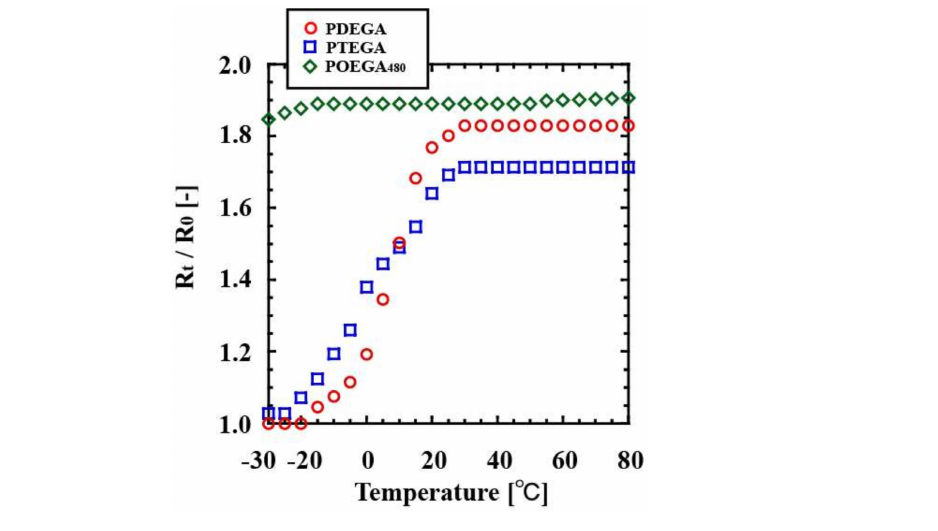
Figure 2. Transition behavior of some gels in ethanol.